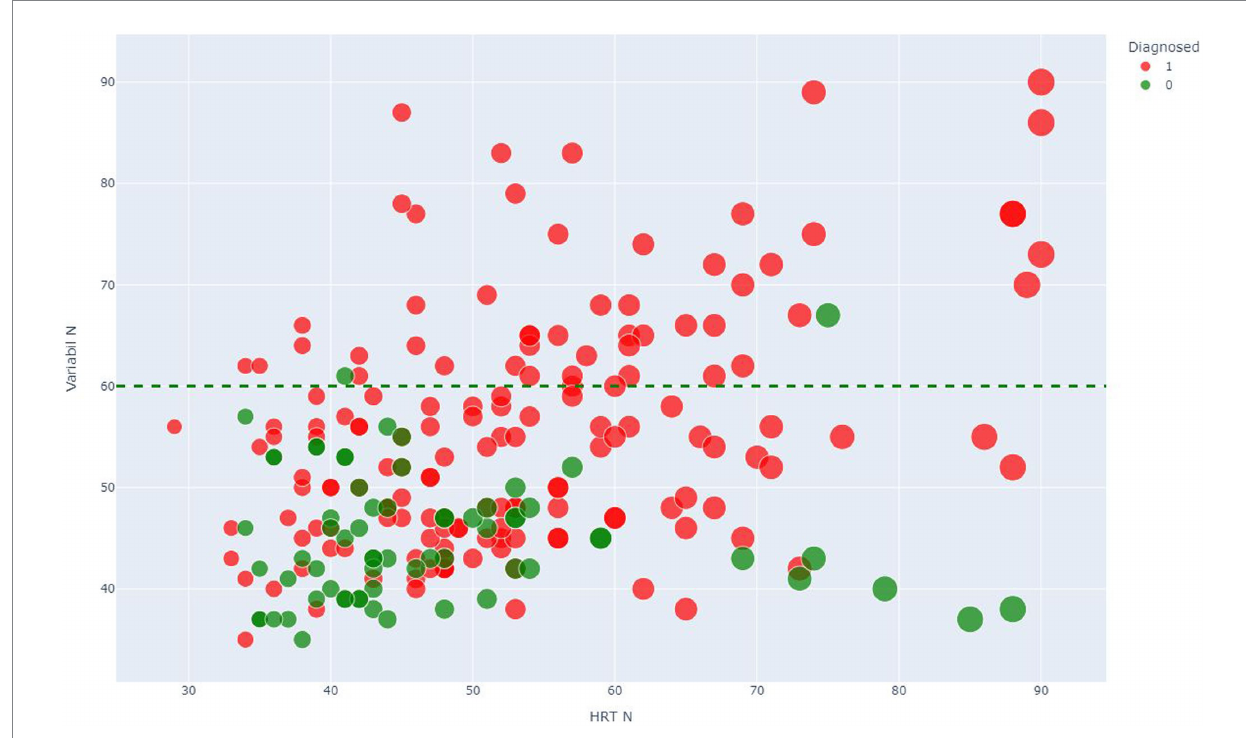
FIGURE 4 Scatter plot showing the discriminant threshold. Scatter plot of Variabil N (vertical axe) and HRT N (horizontal axe) where number 1 (red color) corresponds to P group, and number 0 (green color) corresponds to C